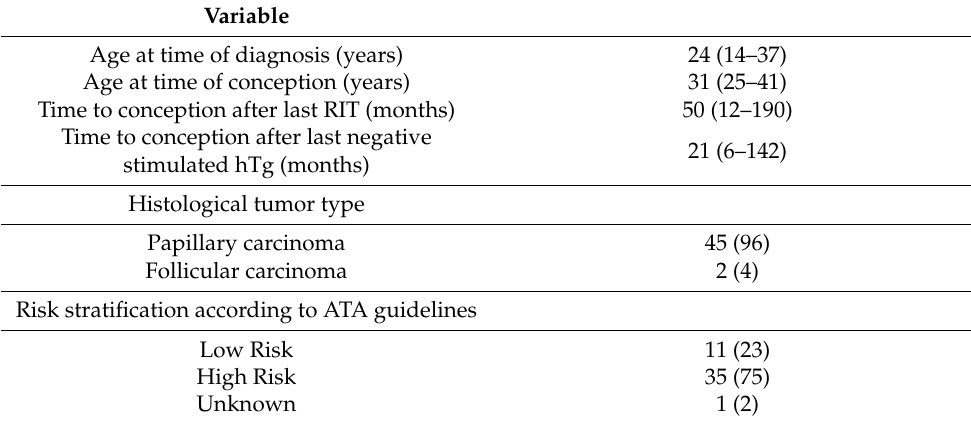
Table 1. Patient